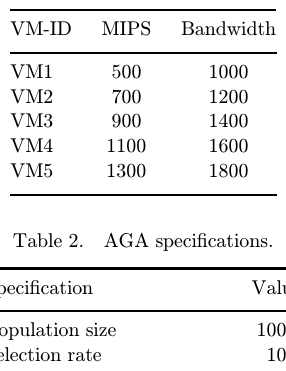
Table 1. Virtual machines speci¯cation.